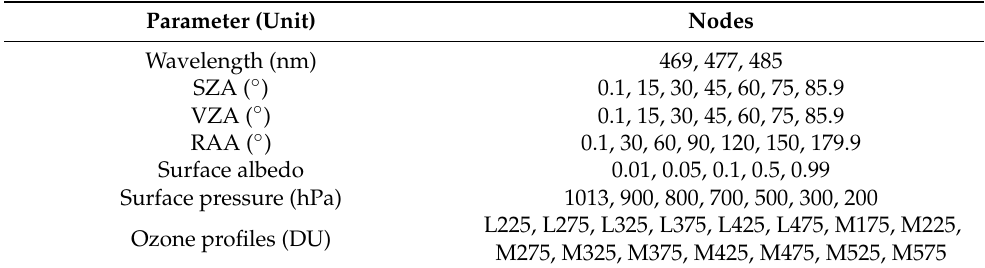
Table 2. Summary of parameters and nodes used to construct the look-up table